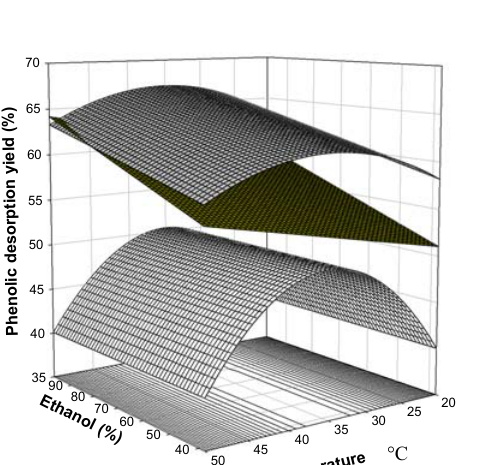
Figure 2. Response surface of the objective functions studied to optimize the desorption stage of phenolic compounds, sugars and radical scavengers from XAD-16HP, SP207 and HP20